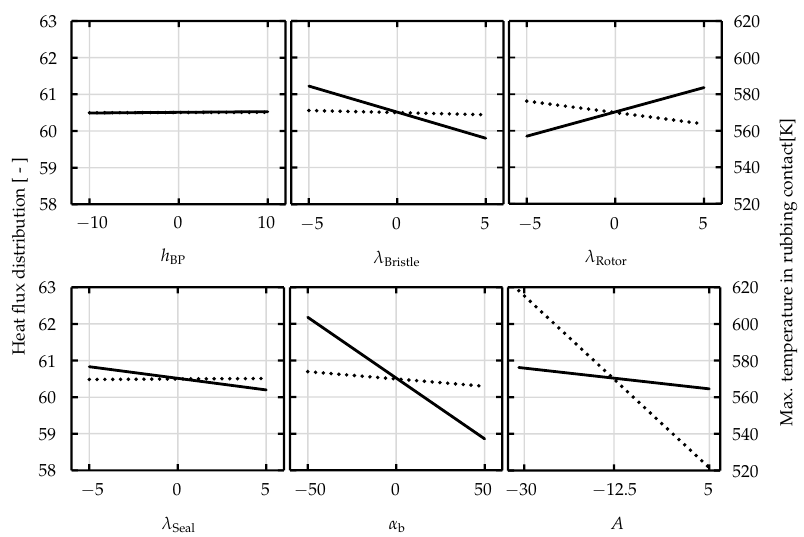
Figure 9. Main effect diagrams for heat flux distribution ( ) and maximum temperature in rubbing contact ( ).